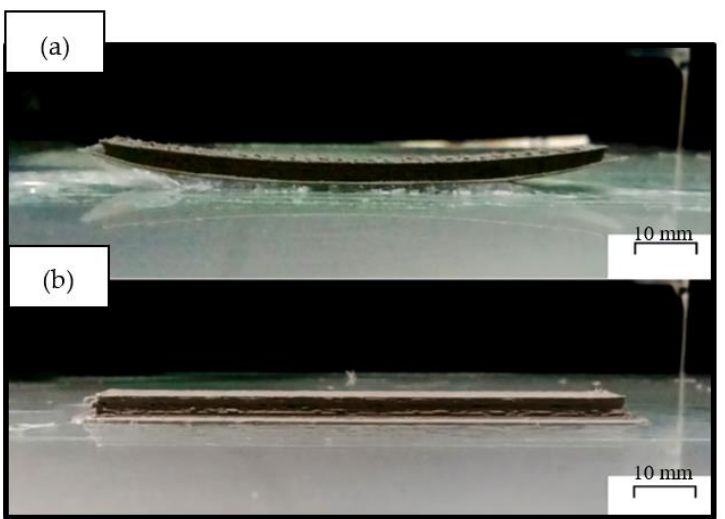
Figure 12. Results of printed samples of Izod impact specimens with rPP material: ( a ) rPP; ( b ) rPP + 10%.